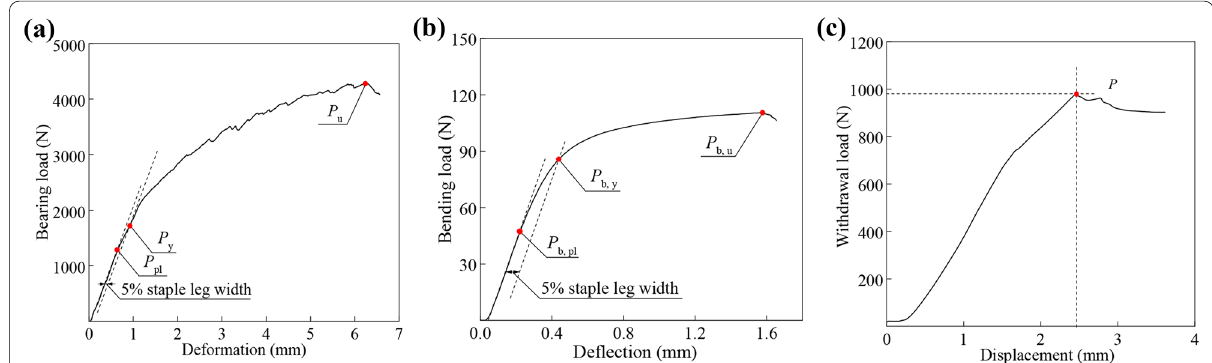
Fig. 9 Typical curves of: a bearing load–deformation of single staple legs tested in half-hole pine plywood test blocks; b load–deflection of single staple legs subjected to center-bending loading; c load–displacement of direct withdrawal of a single staple from pine plywood test blocks